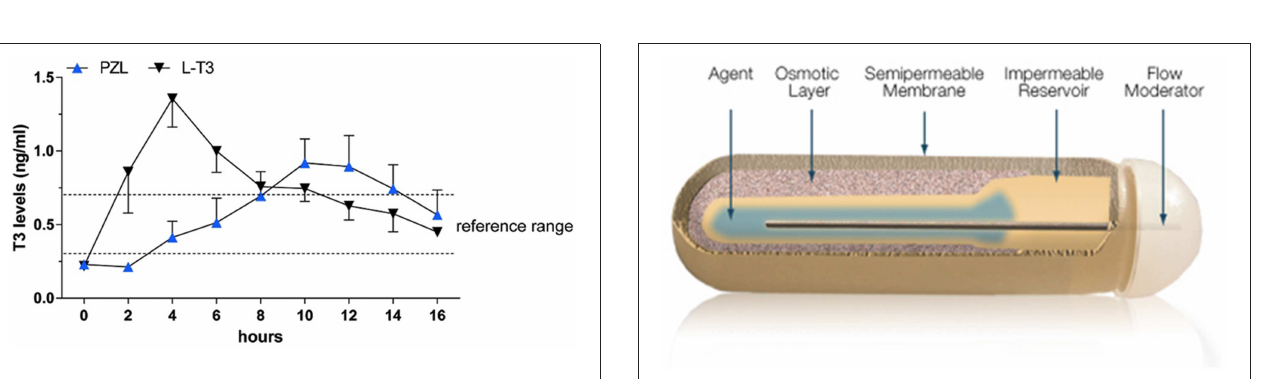
FIGURE 6 | Mechanism of ALZET osmotic pumps which relies on the osmotic pressure difference between pump’s compartments. Reproduced from www.